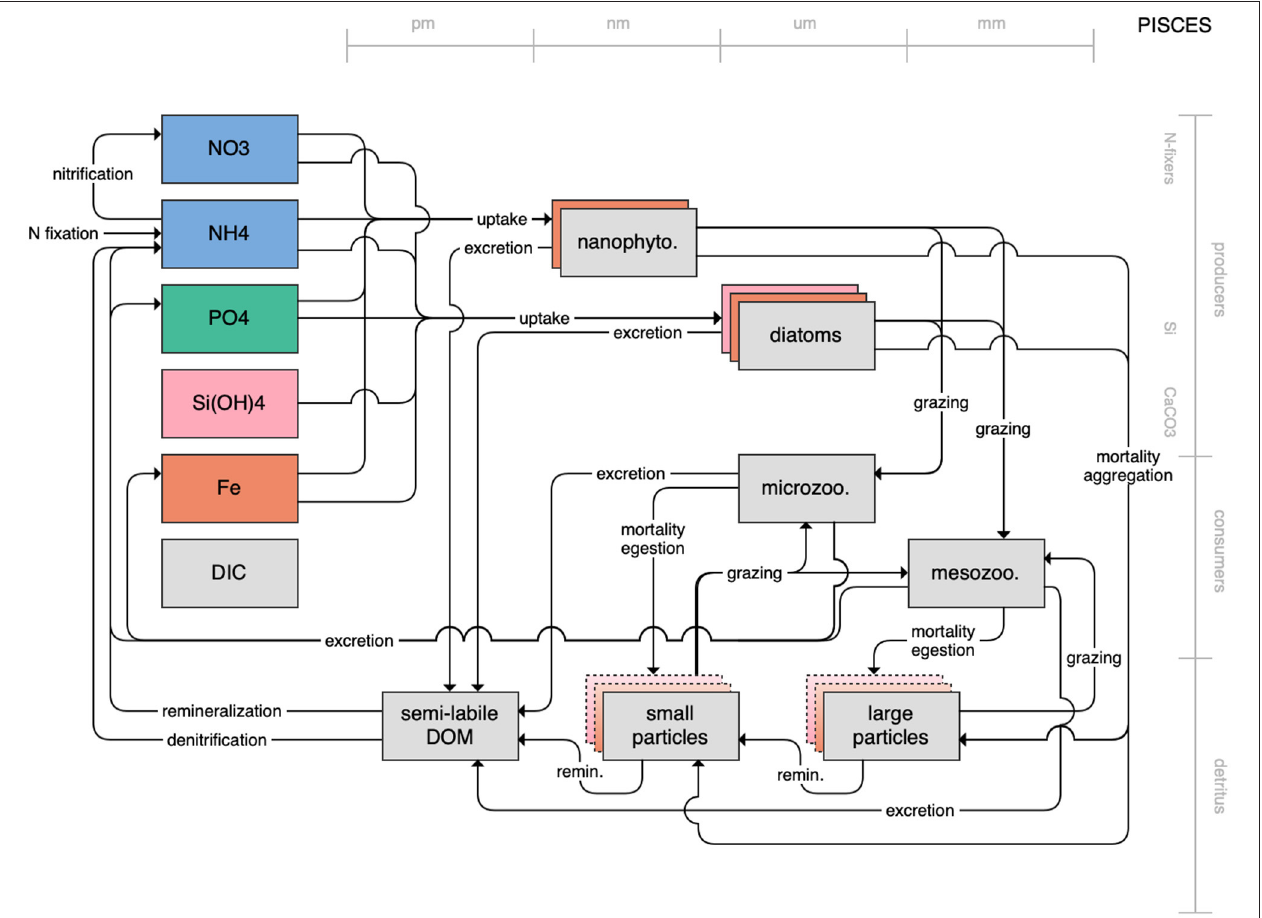
FIGURE 7 | Schematic for the PISCES model. See Figure 1 caption for details.